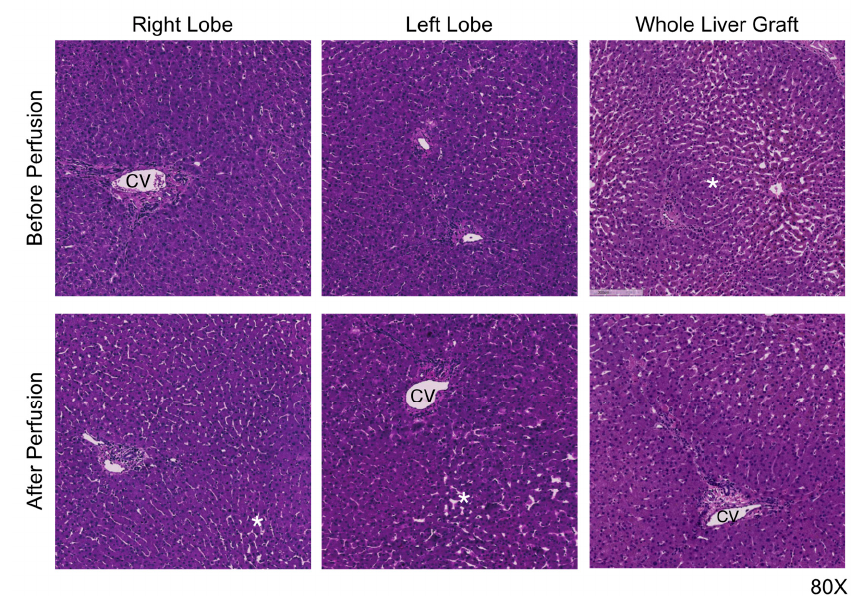
Figure 5. Lobar cellular architecture indicates adequate parenchymal perfusion after splitting. Liver lobules were well preserved during perfusion, with mild sinusoidal congestion and cell swelling, but no increase in ischemic necrosis compared with the preperfusion. No differences were detected between right or left lobes of each individual liver. CV, central vein. * indicates areas of sinusoidal